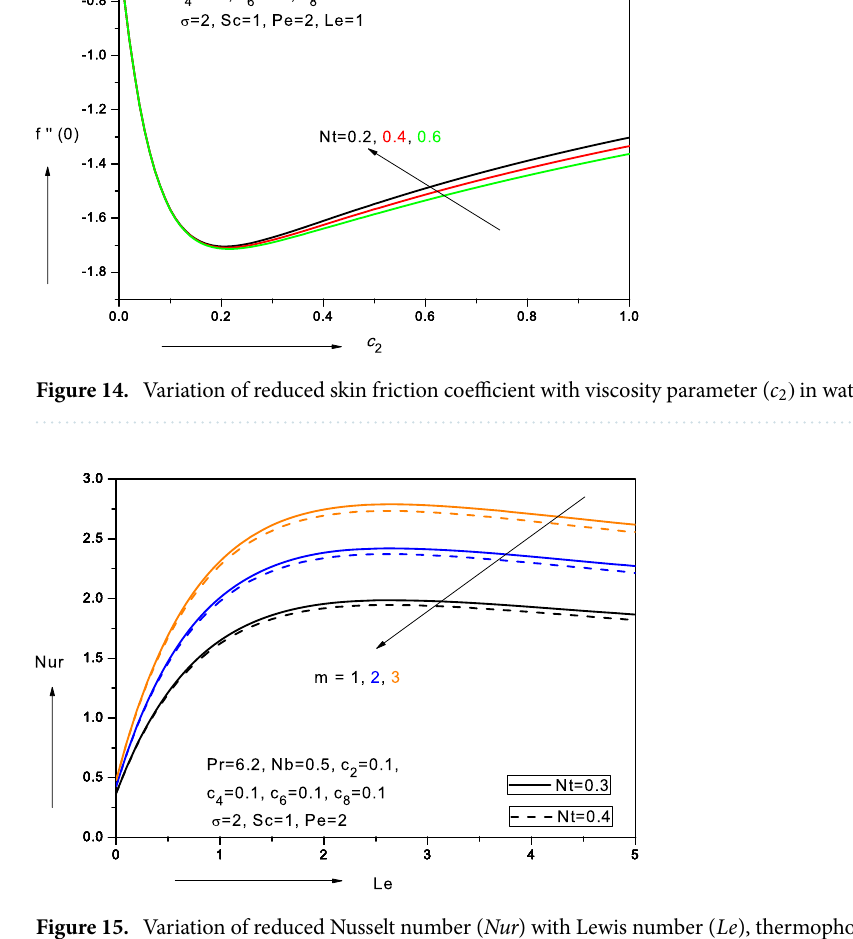
Figure 15. Variation of reduced Nusselt number ( Nur ) with Lewis number ( Le ), thermophoresis parameter ( Nt ) and velocity power-law index ( m ) in water-based nanofluid.